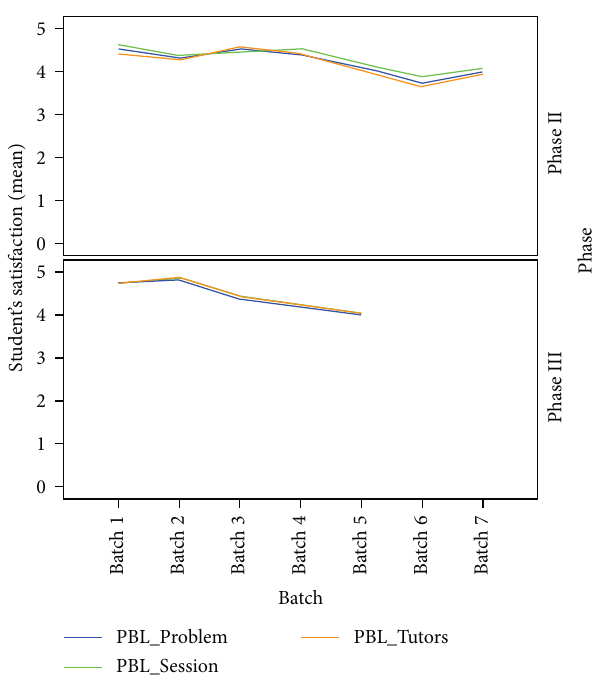
F IGURE 3: Student ’ s satisfaction regarding different factors of the PBLs based on level of study, i.e., from phase 2 and